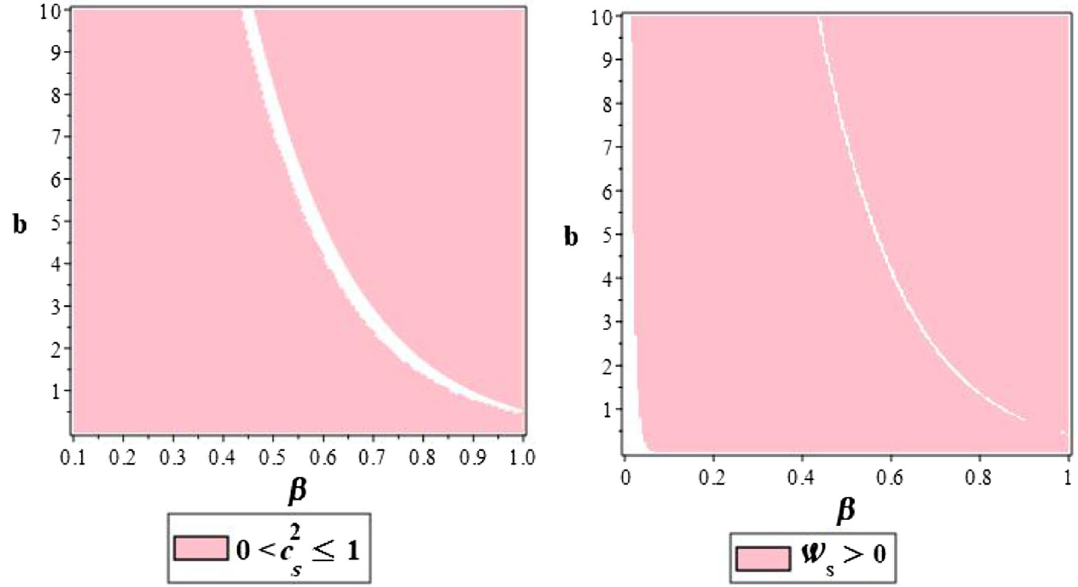
Fig. 1 Ranges of the model’s parameters that lead to the gradient instability-free intermediate MDBI inflation (left panel) and the ghost instability- free intermediate MDBI model (right panel). These figures have been plotted for N = 60